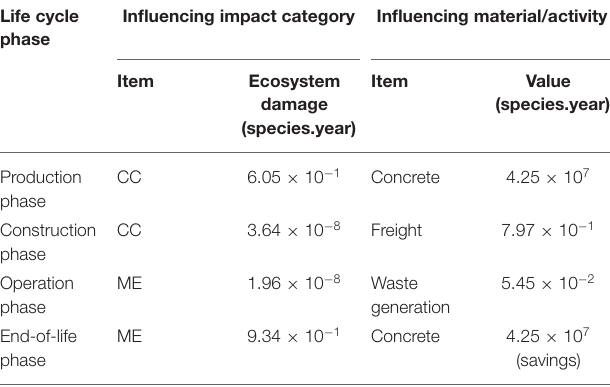
TABLE 7 | Influencing factors on ecological quality for Ras Abu Aboud Stadium case study. Life cycle